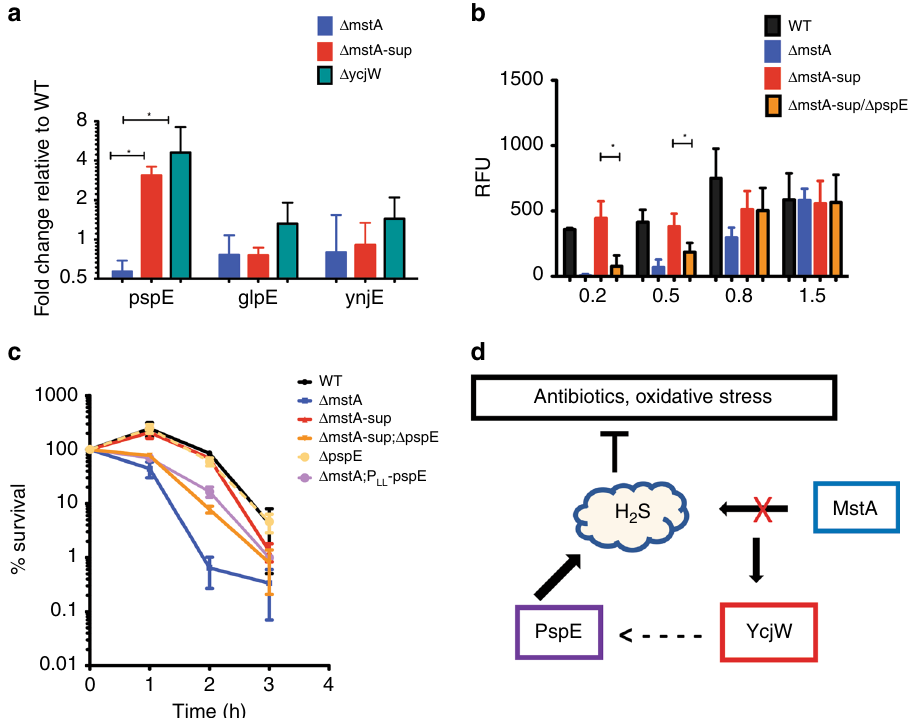
Fig. 4 Deletion of pspE in Δ mstA -sup decreases H 2 S biosynthesis during exponential growth. a qRT-PCR of three thiosulfate sulfurtransferase genes. RNA was isolated from cells grown to OD 600 ~ 0.4. Only pspE expression was signi fi cantly increased in both Δ mstA -sup and Δ ycjW . Values are means± SD ( n = 3). * p < 0.05 as determined by the Student's t test. b H 2 S levels in Δ mstA -sup; Δ pspE were undetectable till OD 600 reached 0.8. Values are means ± SD ( n = 3). * p < 0.05 as determined by the Student's t test. c Δ mstA -sup/ Δ pspE had increased sensitivity to gentamicin compared with WT and Δ mstA -sup. Overexpression of pspE in Δ mstA increased tolerance to gentamicin compared with Δ mstA . Values are means ± SD ( n = 3). d In cells lacking MstA which is responsible for H 2 S production, S258N YcjW upregulates PspE as an alternate route of H 2 S biosynthesis. Source data are provided as